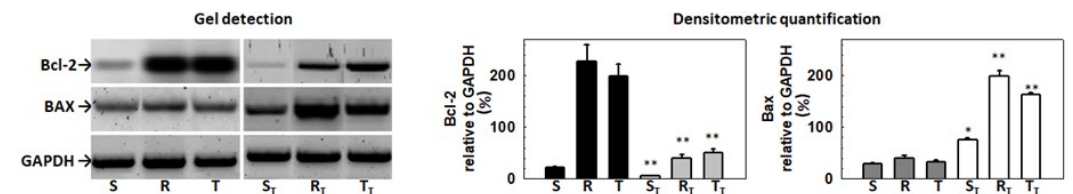
Figure 5. Detection of Bcl-2 and BAX protein levels in S, R and T cells incubated for 24 h in cultivation medium in the absence (S, R, and T) or presence of TBT-Br (S T , R T and T T ). The blots records are representative of three independent measurements. GAPDH was used as a housekeeping protein. Immunostained protein bands were quantified by densitometry, and protein quantity is documented